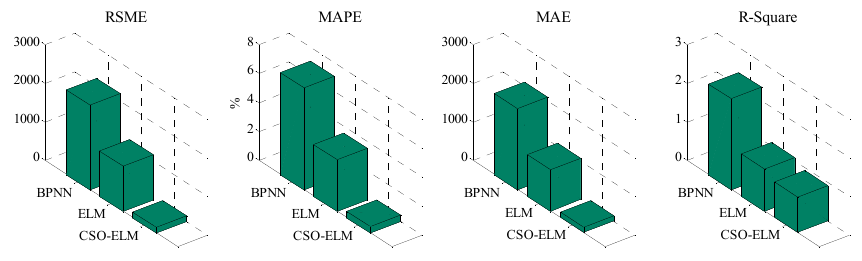
Figure 4. Errors of three methods.